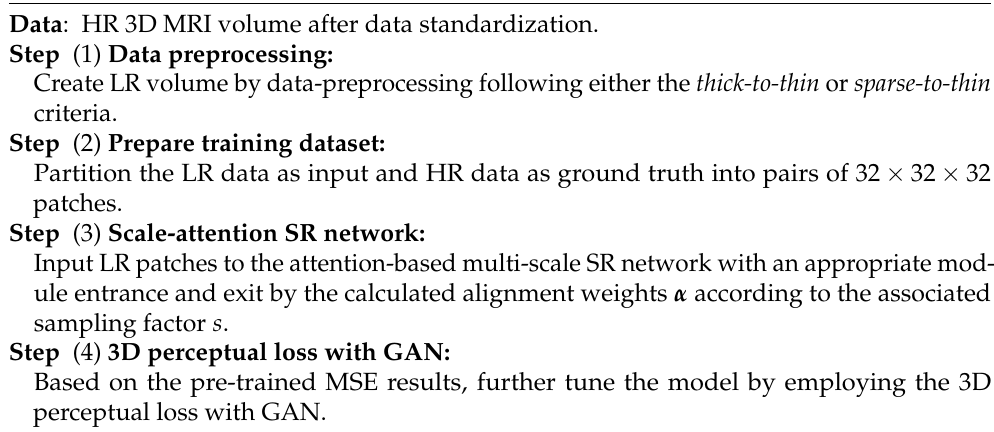
Algorithm 1 Training the proposed framework SOUP-GAN.